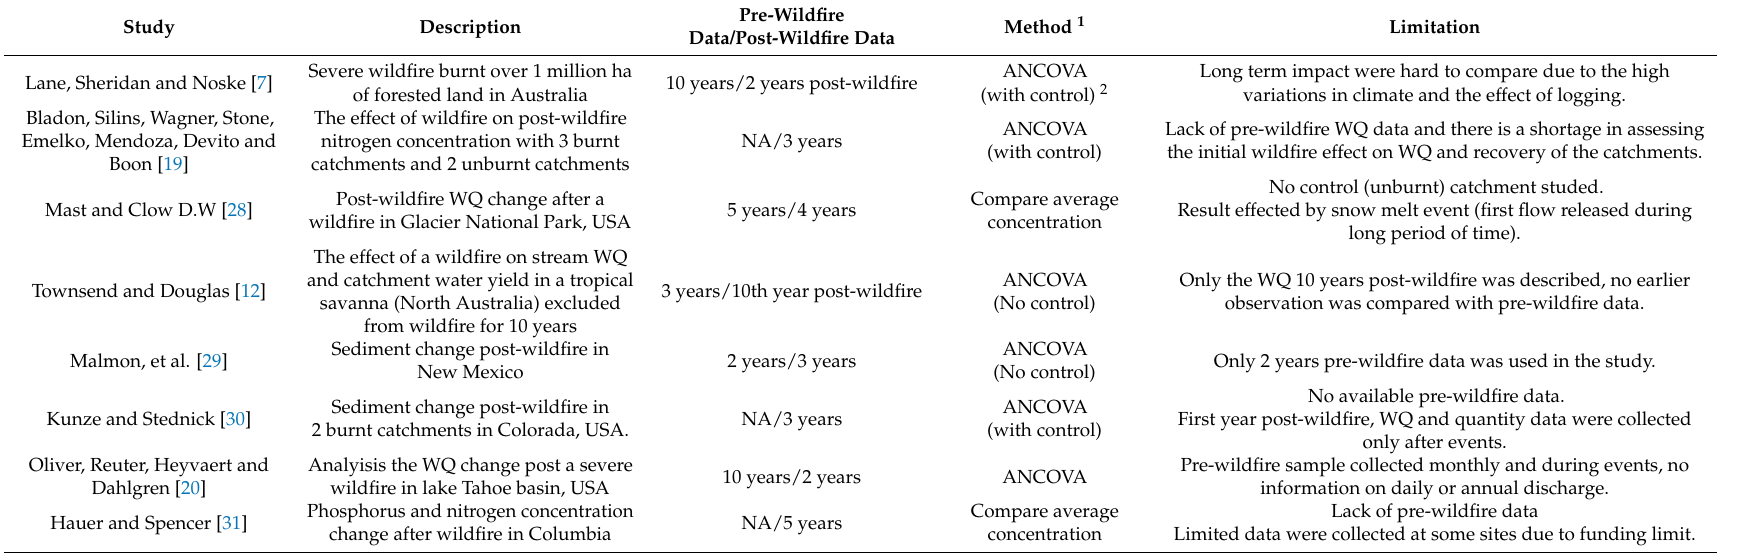
Table 1. Past Studies on wildfire effect on